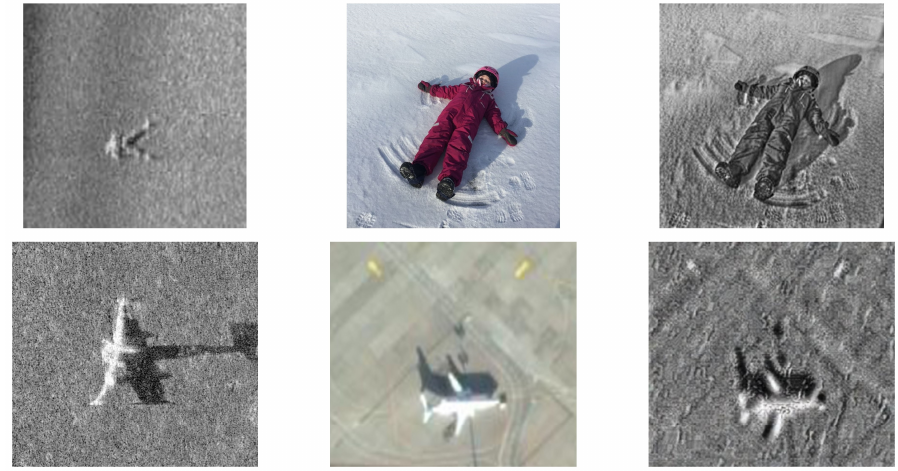
Figure 8. Real SSS images, original optical images and simulated SSS images after ST. The first, second and third columns are style images, optical images and simulated SSS images, respectively.